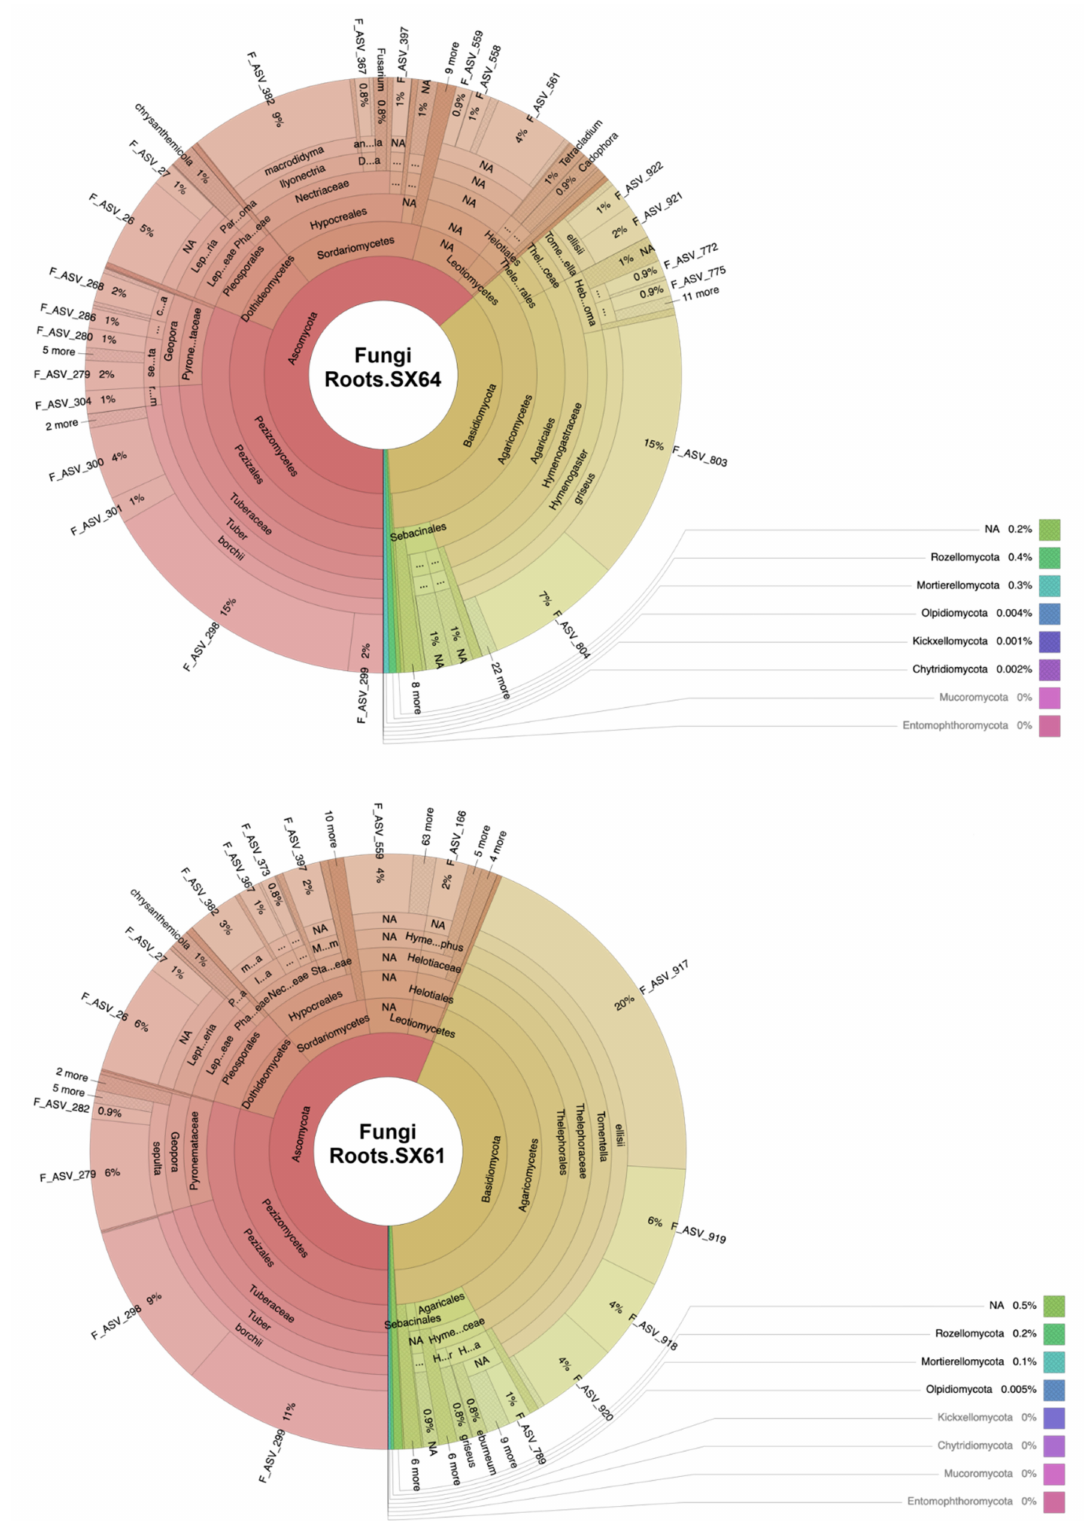
Figure 2. Krona charts of raw read counts of all fungal ASVs in each biotope of both Salix cultivars. Arc lengths are proportional to the relative number of reads by group (Rhizo.SX64 = 684,598 reads; Rhizo.SX61 = 596,370 reads; Roots.SX64 = 95,896 reads; and Roots.SX61 = 116,080 reads). The interactive Krona charts are available at https://github.com/MaximeFortinFaubert/Figure2/blob/ main/README.md (accessed on 1 December